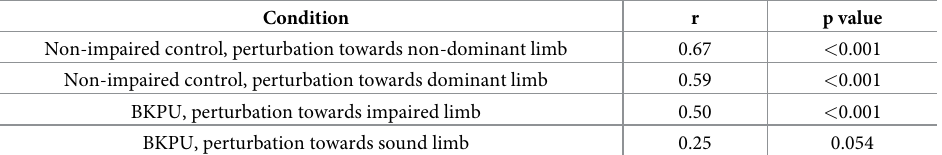
and CoM exposure